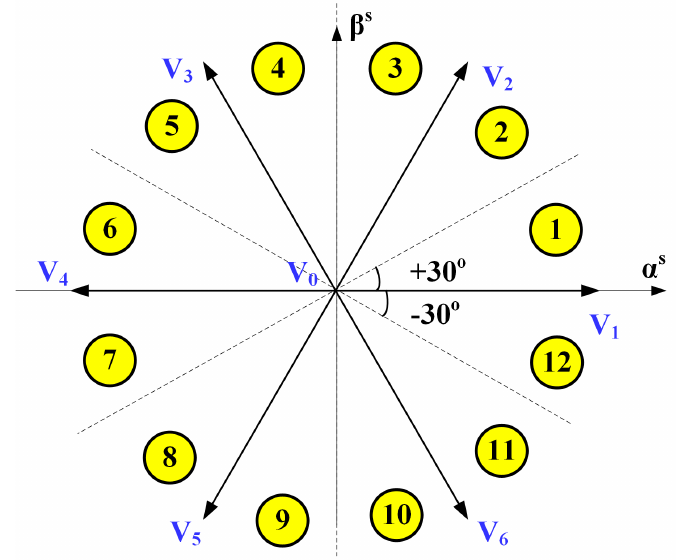
Figure 2. Dividing the stator flux path into twelve